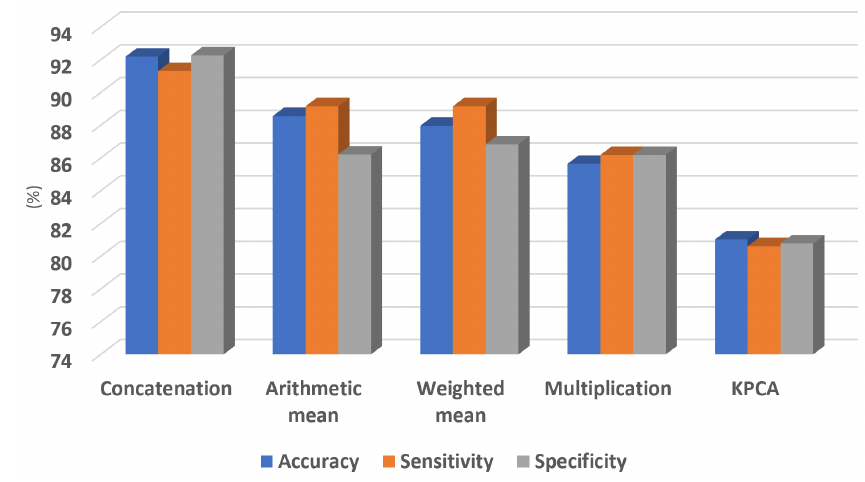
Figure A2. Comparison between the classifier level fusion